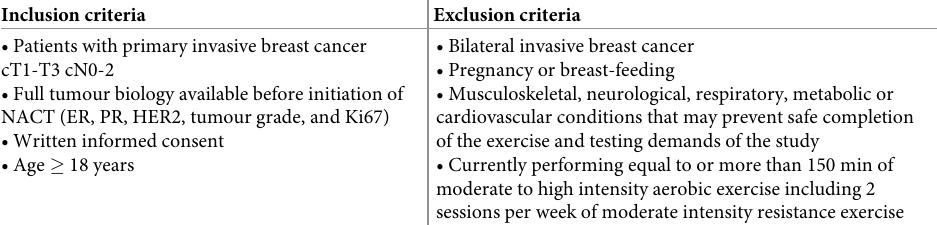
Table 1. Inclusion and exclusion criteria in the Neo-ACT